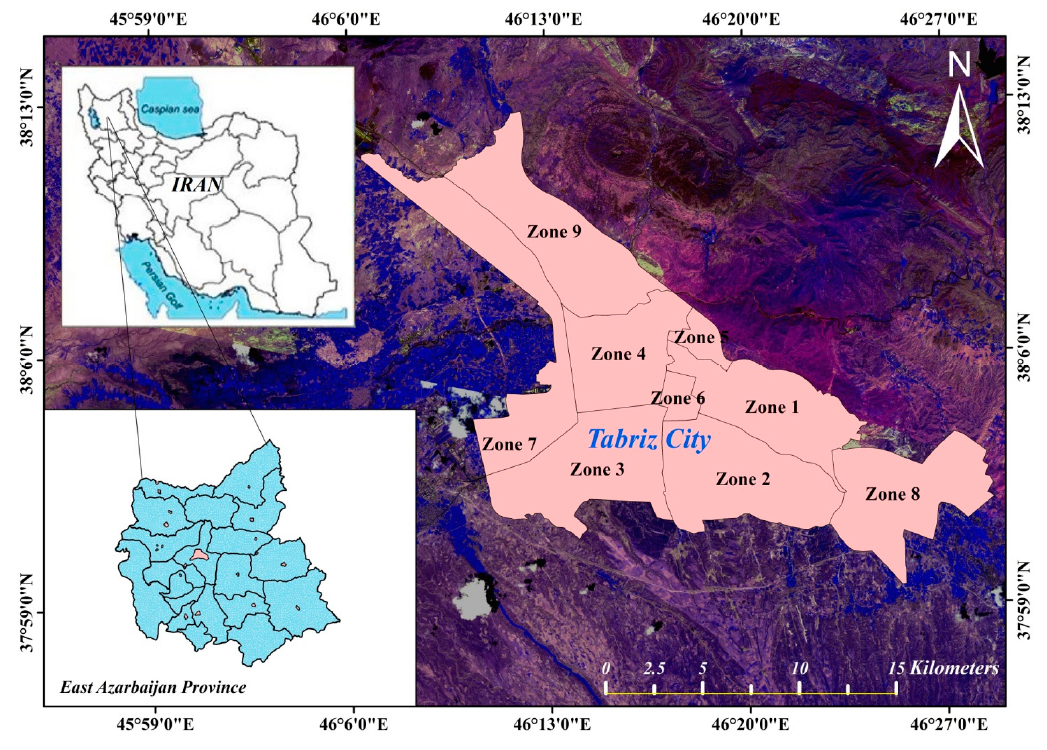
Figure 1. Geographical location of the East Azarbaijan province and Tabriz city in relation to the political provincial and national border.